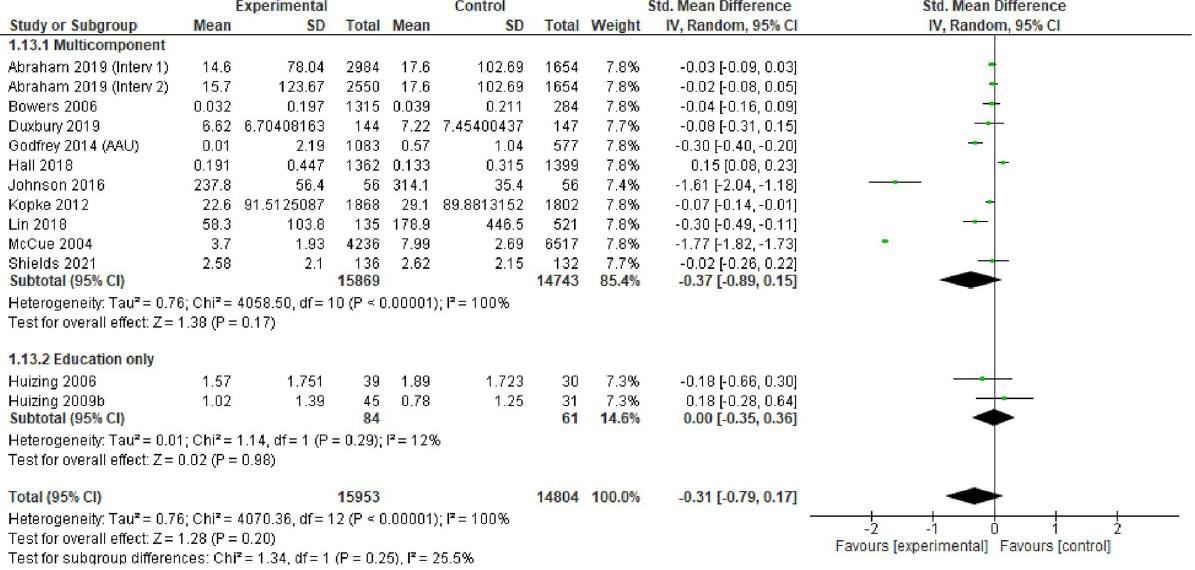
Fig 9. Effectiveness of interventions on the use of restraint by intervention type, excluding outliers.